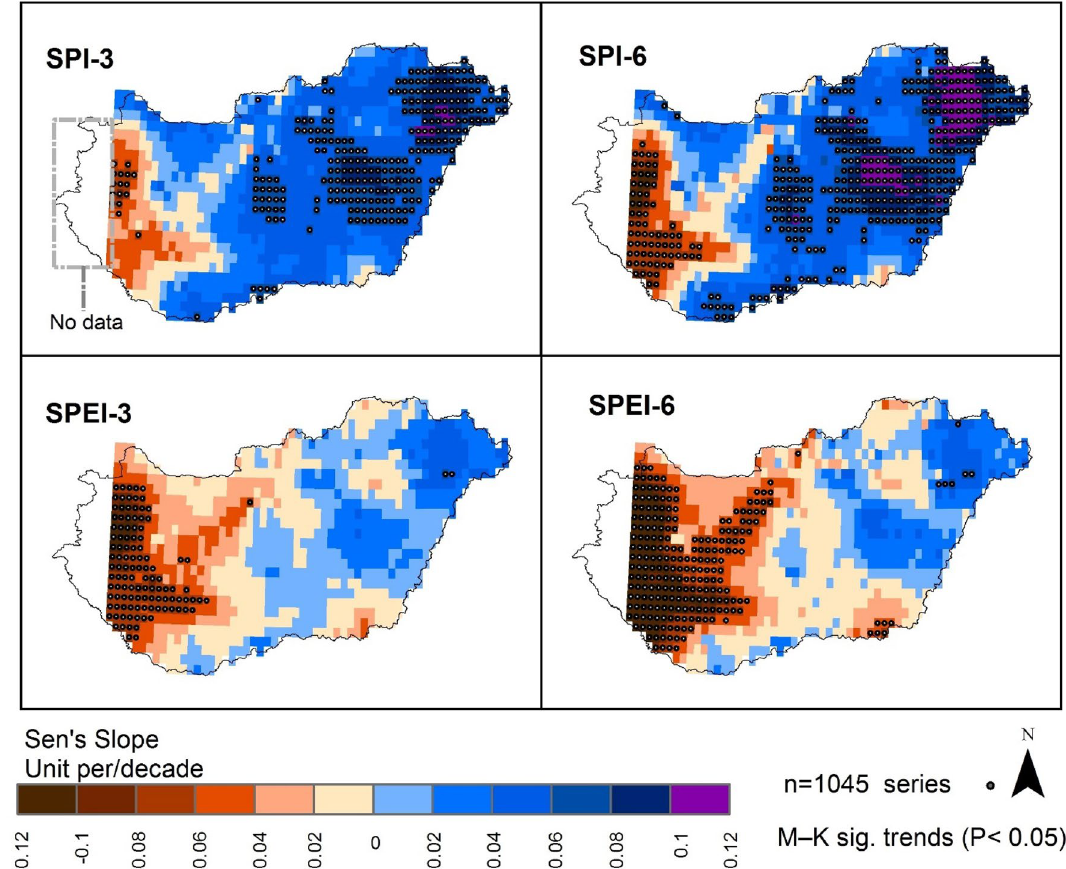
Figure 3. The SPI Sen’s Slopes and its trends for Hungarian territory from 1961 to 2010 (maps were generated using ArcGIS 10.5 (https:// www. esri. com/ en- us/ about/ about- esri/ overv